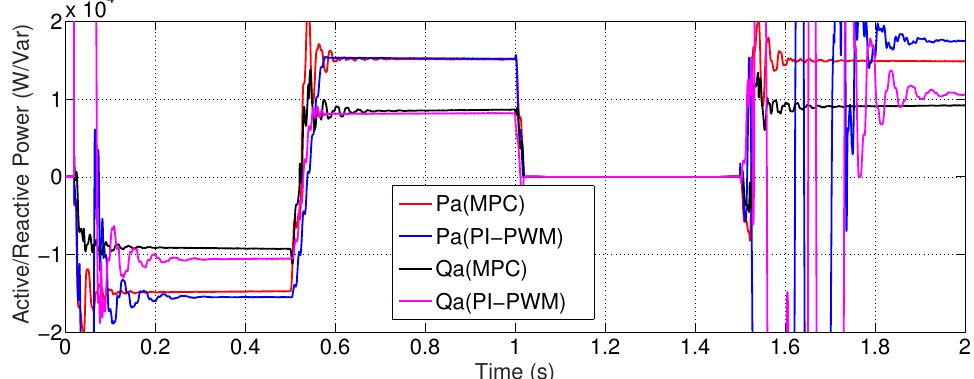
Figure 3. Comparison of the results for the active and reactive power exchange with the main grid between the Model Predictive Control (MPC) and PI-PWM controllers for phase a